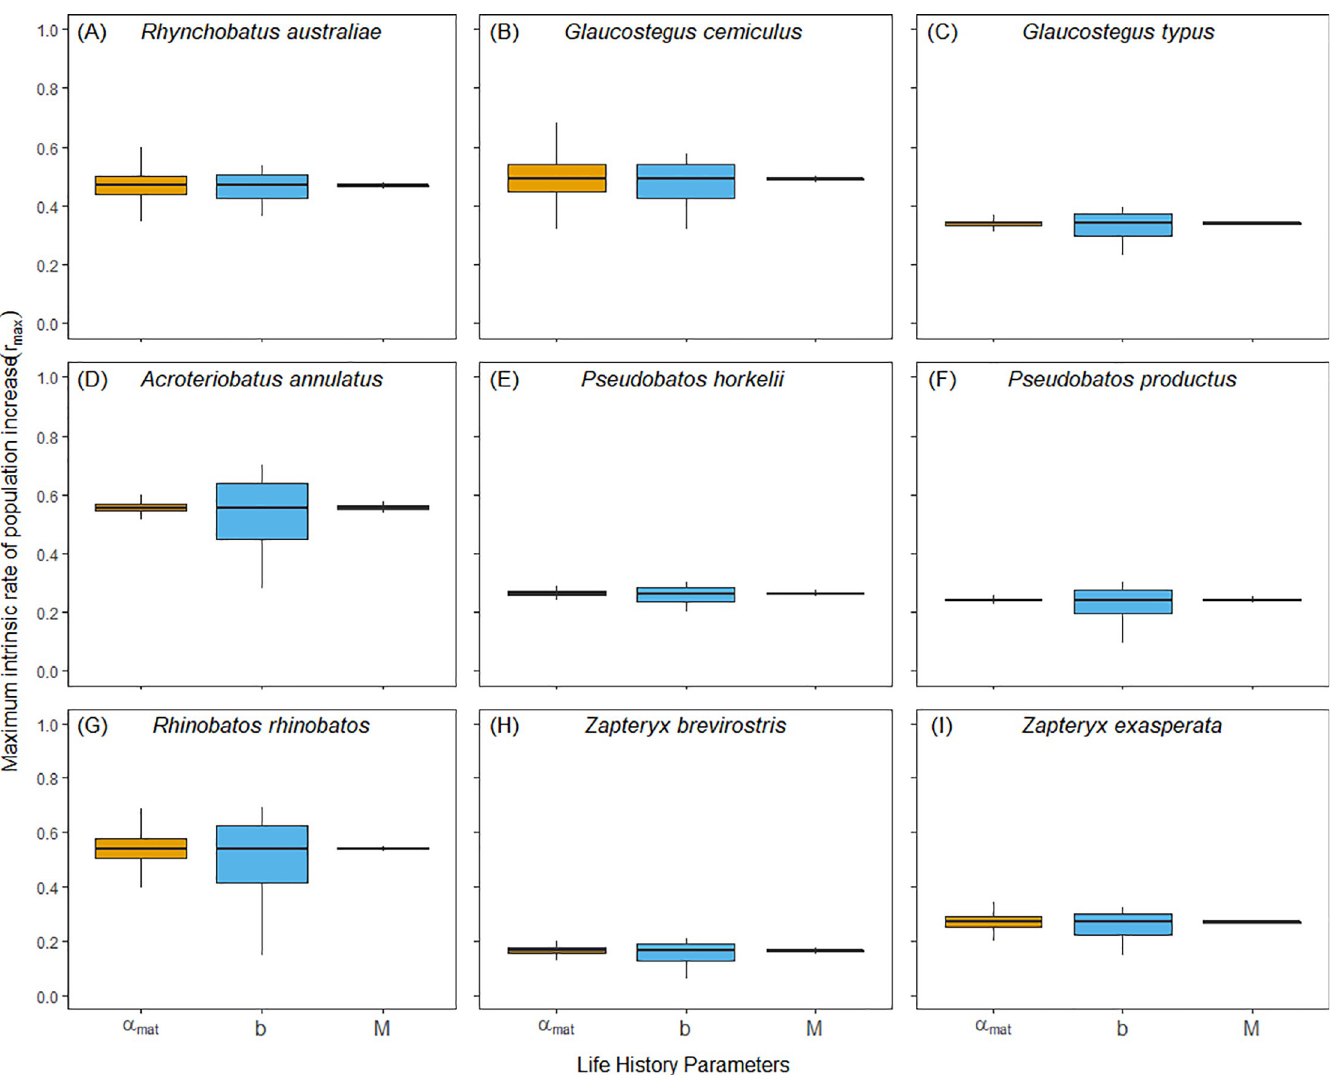
Fig 1. Incorporating uncertainty in the model parameters when predicting values of r max (year -1 ) for nine shovelnose rays species. When including uncertainty in , first/orange boxplot), annual reproductive output ( b , middle/blue boxplot), and reciprocal of the lifespan natural mortality estimator ( M , last/grey age at maturity ( α mat boxplot). Species are (A) R . australiae , (B), G . cemiculus , (C) G . typus , (D) A . annulatus , (E) P . horkelii , (F) P . productus , (G) R . rhinobatos , (H) Z . brevirostris , and (I) Z . exasperata . Boxes indicate median, 25 and 75% quantiles, whereas the lines encompass 95% of the values (2.5 and 97.5% quantiles). For plots incorporating uncertainty with other natural mortality methods, see S2 Appendix.